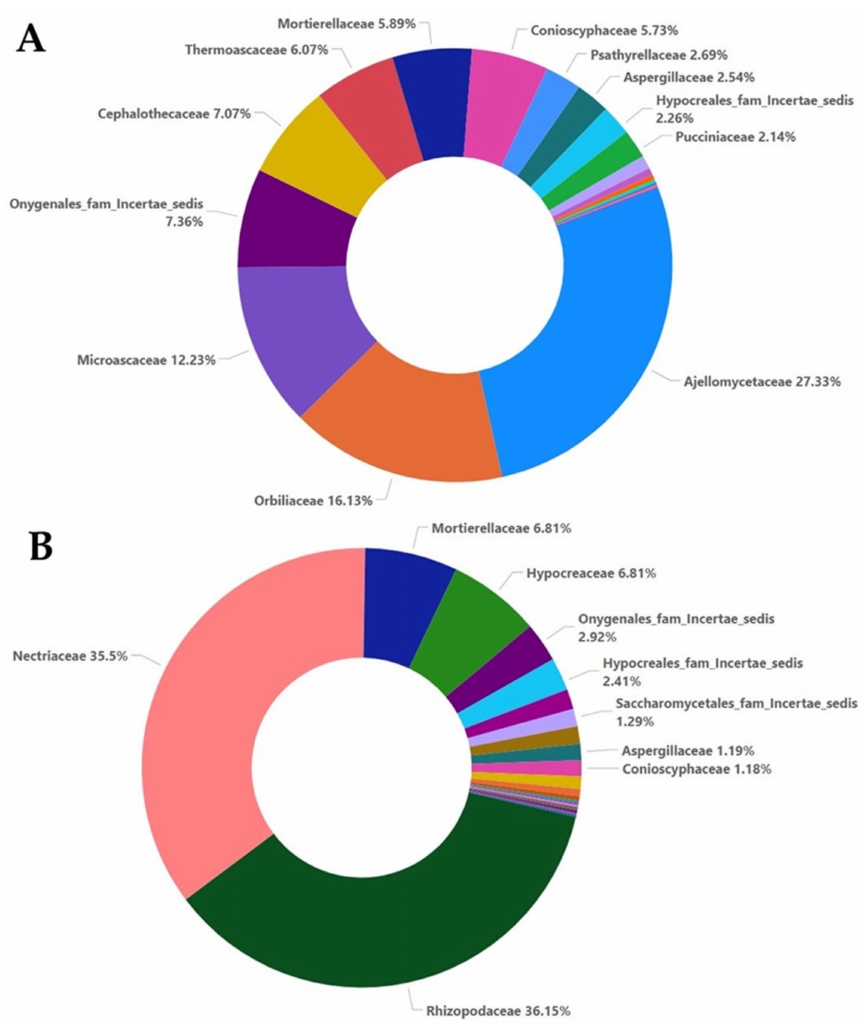
Figure 5. Relative abundance with percentages for the family taxa at a 5% concentration of essential oil for the non-inoculated samples ( A ) and inoculated samples ( B